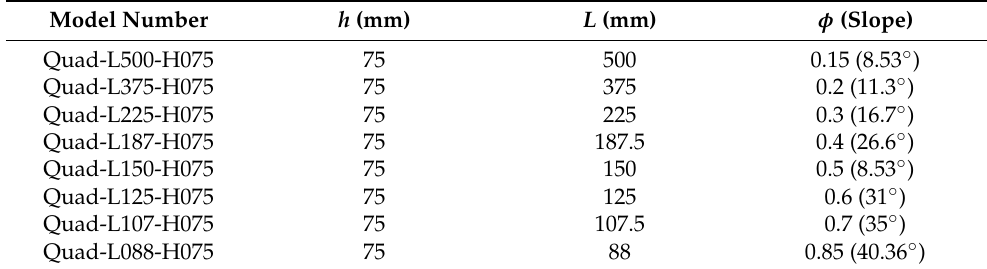
Table 2. Parameter settings for hill